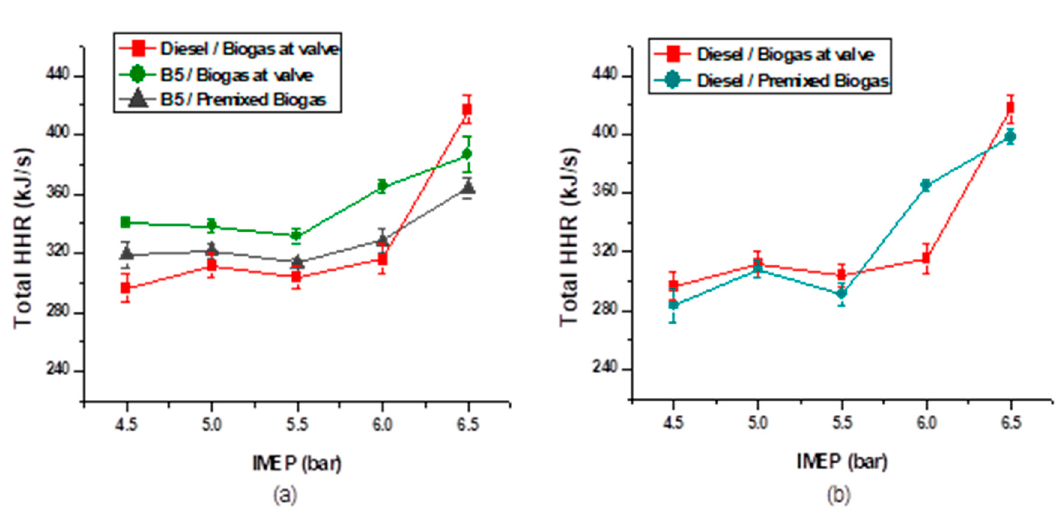
Figure 8. Variation of total heat release rate (HRR) for ( a ) B5 / biogas RCCI in a premixed and injection at the valve and ( b ) diesel / biogas in a premixed and port injection at the valve.